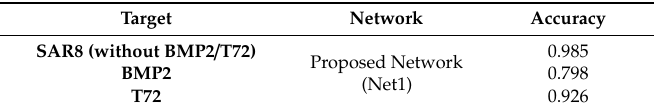
Table 13. Performance of SAR8 / BMP2 / T72.